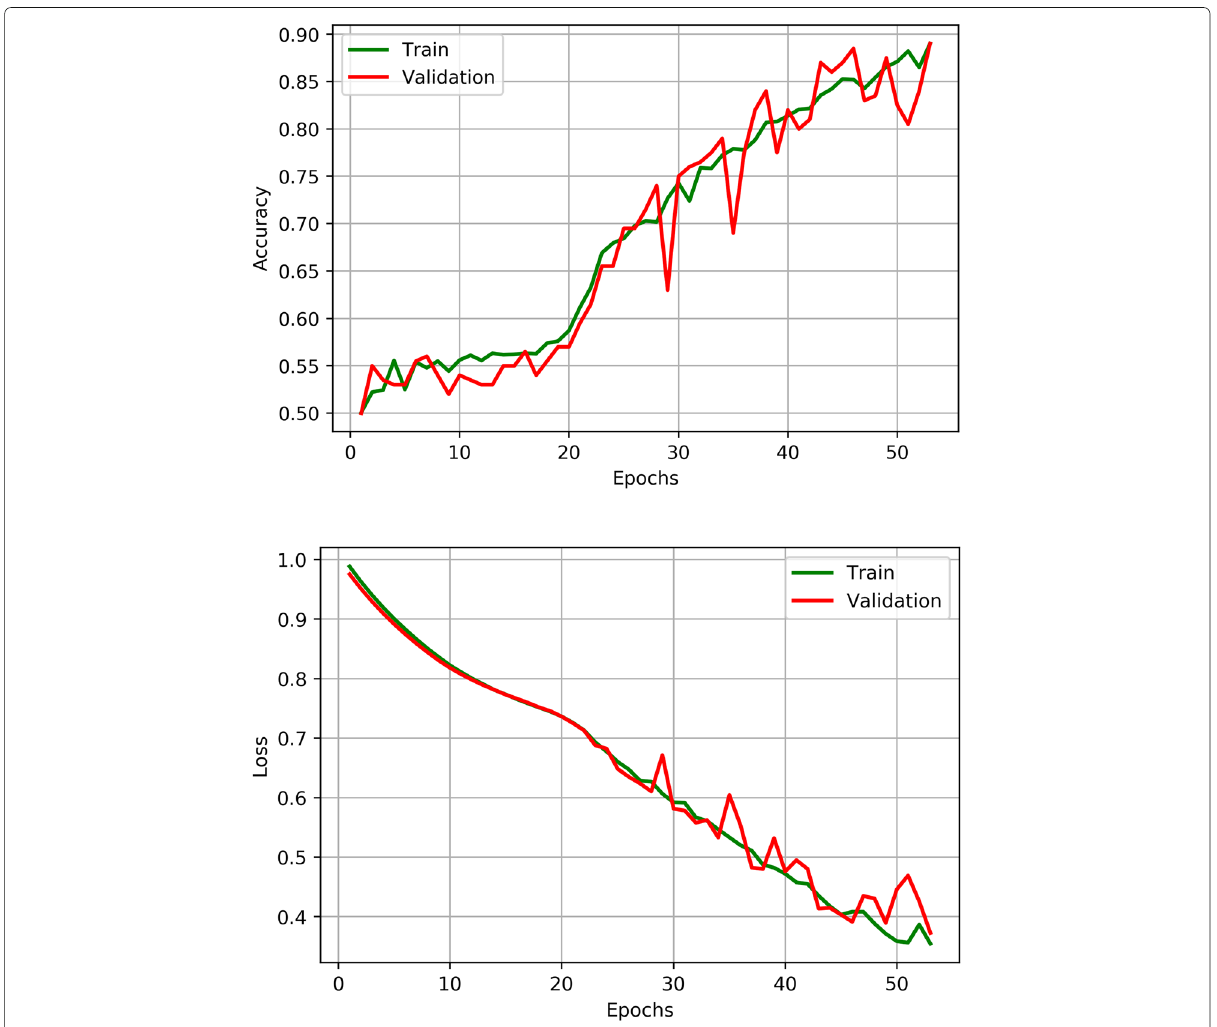
at that moment. Some comments may also include sar- casm that makes it difficult to achieve the right result.